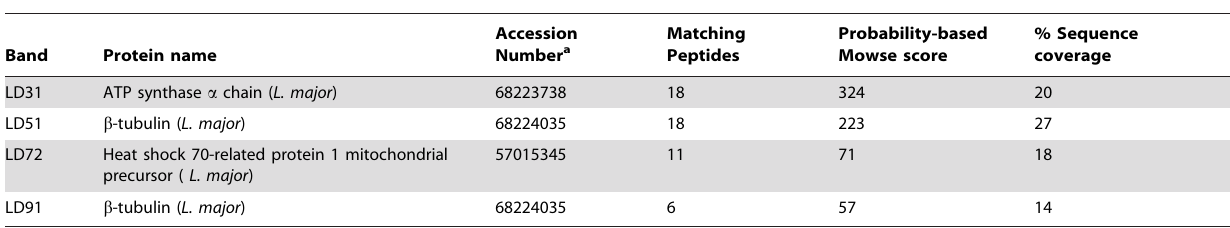
Table 1. Proteins identified by MALDI-TOF/TOF mass